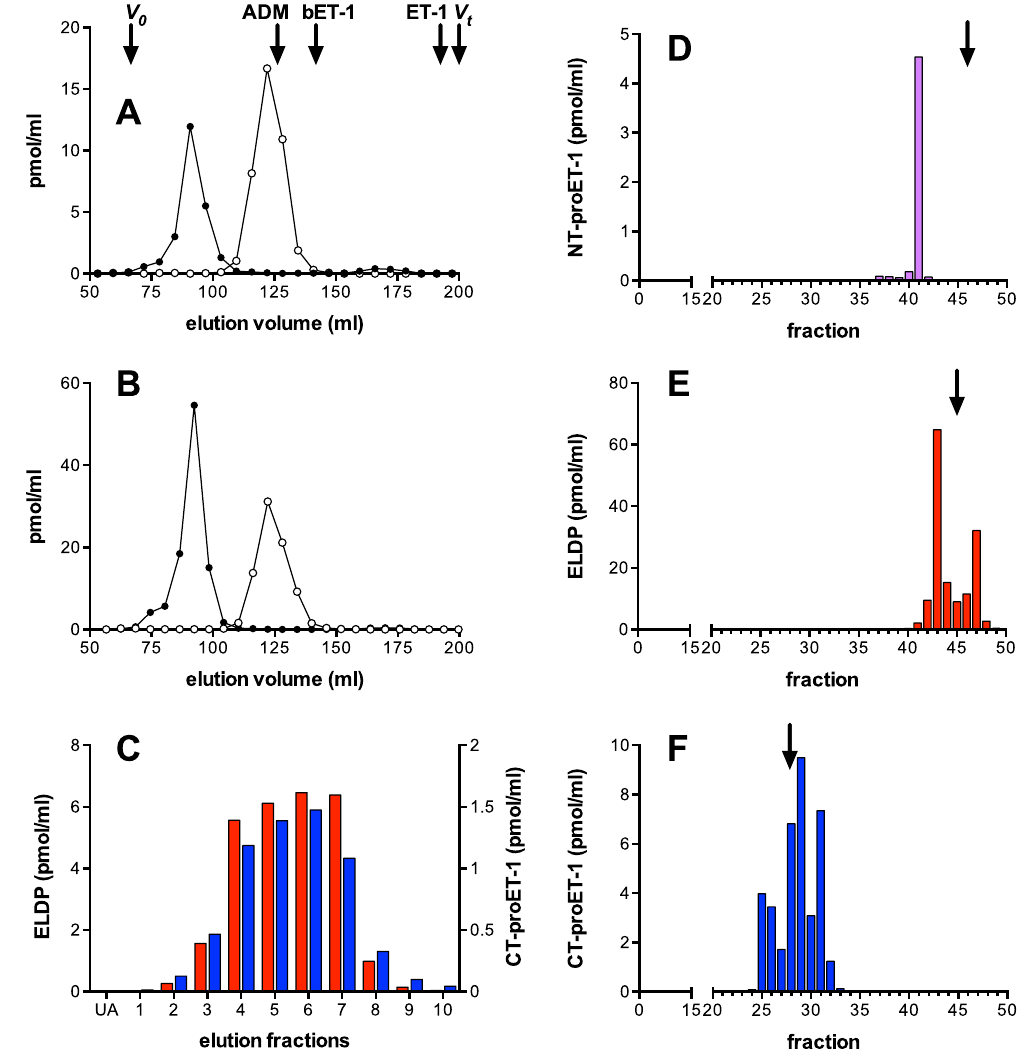
Figure 2. Size exclusion chromatography of peptide precipitates from ( A ) EA.hy 926 and ( B ) A549 cell lines, ( C ) cation exchange chromatography of conditioned media from EA.hy 926, and HPLC characterisation of pro-ET-1 peptides from EA.hy 926 cells – ( D ) NT-proET-1, ( E ) ELDP and ( F ) CT-proET-1. ( A ) and ( B ) proendothelin-1 peptides from EA.hy 926 and A549 cell lines were subjected to size exclusion chromatography (column 1.6 × 100 cm, Sephadex G50 superfine) equilibrated at 4 °C with 0.1 M NaCl containing 0.01 M HCl. Fractions were subjected to immunoassay for ppET-1 [42–50] (open circles) and ppET-1 [93–102] (closed circles). Elution positions of adrenomedullin (ADM, M r 6029), big ET-1 (bET-1, M r 4283) and ET-1 ( M r 2492) are indicated. ( C ) Cation-exchange chromatography of 300 ml of acidified (1.25% acetic acid) conditioned medium from EA.hy 926 cells loaded onto ten Fractogel CEx columns (bed volume 2.8 ml each) after Q-Sepharose FF pre-treatment. After rinsing with 10 mM acetic acid (10 ml/column) to remove unadsorbed material (UA), columns were eluted sequentially (3 ml each) with: (1) 0.125 M NaCl, (2) 0.25 M NaCl, (3) 0.25 M NaCl + 0.1 M G-HCl, (4) 0.5 M NaCl + 0.1 M G-HCl, (5) 1 M NaCl + 0.1 M G-HCl, (6–10) 1 M NaCl + 0.5 M G-HCl. ELDP (red columns) and CT-proET-1 (blue columns) were measured using immunoassays. ( D ), ( E ) and ( F ) peak fractions of NT-proET-1, ELDP and CT-proET-1 from semi-preparative RP-HPLC were pooled and subjected to separate RP-HPLC purification (ACE-5 C4 300 Å, 5 µ m, 4.6 × 250 mm) with gradient elution (1 ml/ min) 0.1% TFA – 10% solvent B (80% CH 3 CN with 0.1% TFA) over 2 min, followed by 10–30% B over 50 min. Fractions (1 min) were subjected to specific sandwich immunoassay to identify peak fractions for LC-MS/MS characterisation. Arrows mark the elution positions of synthetic NT-proET-1, ELDP and CT-proET-1; which eluted in fractions 46, 45 and 28,